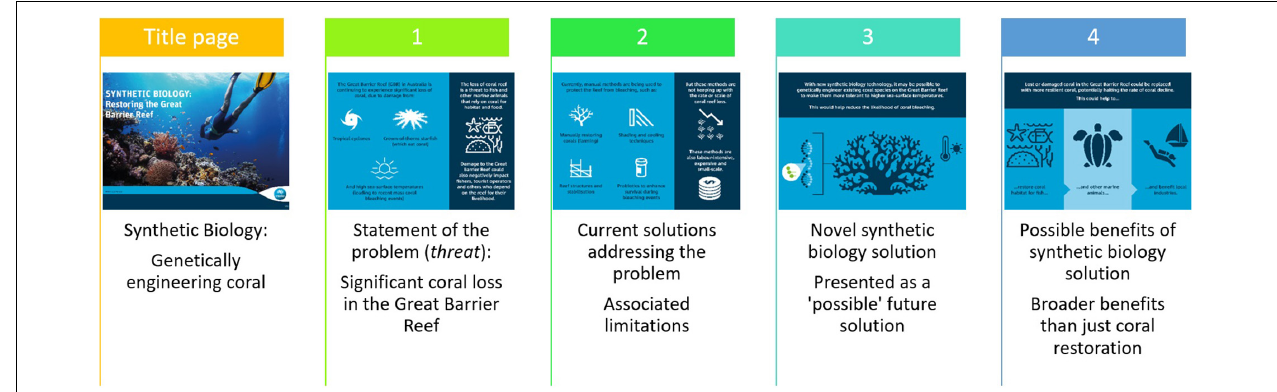
FIGURE 1 | Technology storyboard for genetically engineering coral; this storyboard was the “technology” reference for all responses within the survey.